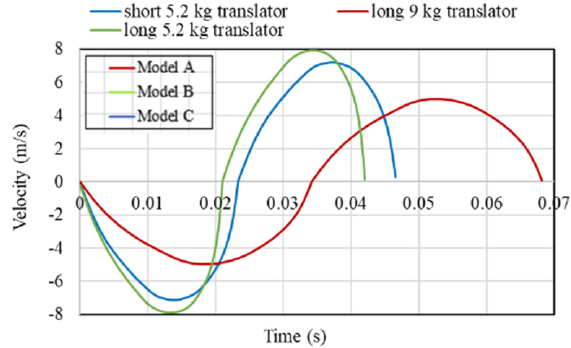
Figure 21. Velocity versus time for load of 5 Ohms .